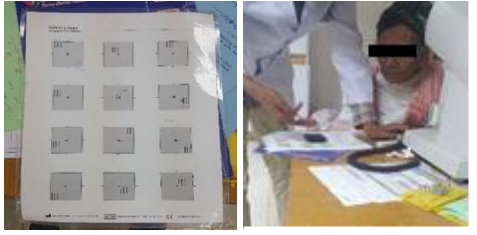
Figure 10. Left: FDT training manual with an illustration of stimuli. Right: An ophthalmic nurse is giving an explanation to a patient, using the